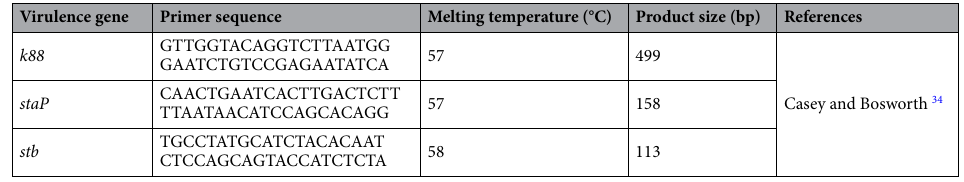
Table 3. DNA sequence of PCR primers for virulence